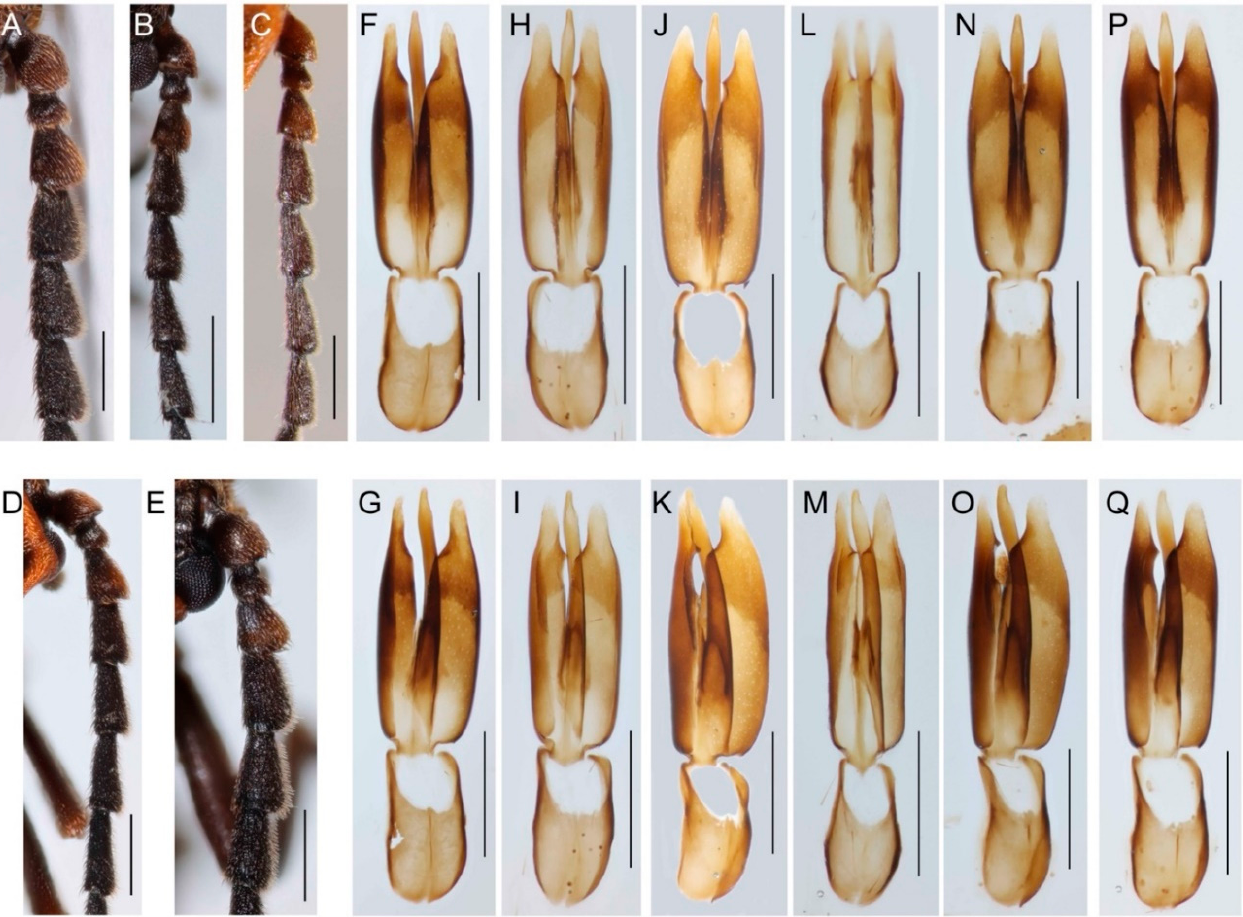
Figure 3. ( A – C , F – K ) Dictyoptera aurora and ( D , E , L – Q ) D. coccinata . ( A – E ) Antennomeres 1–6; ( F – Q ) Male genitalia, dorsal (upper row), and ventrolateral views (bottom row). Each column of the genitalia figures contains two views of the same individual. Scales: 0.5 mm.